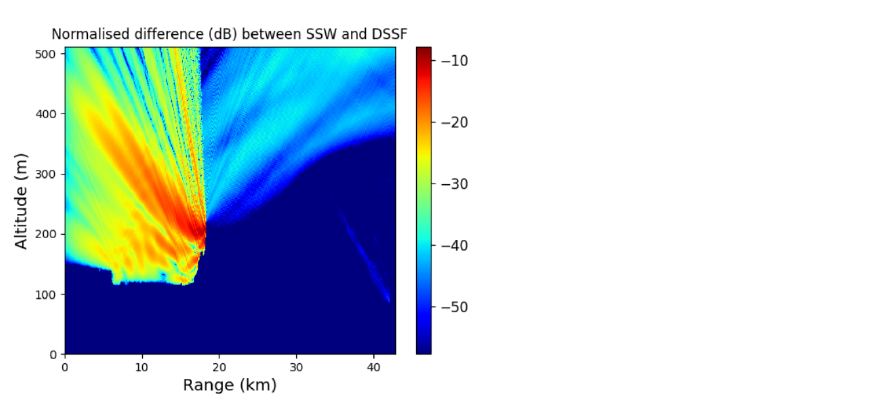
Figure 10. Prediction of the radar coverage for the Toulouse airport using the one-way and two-way methods. ( a ) One-way method. ( b ) Two-way method.